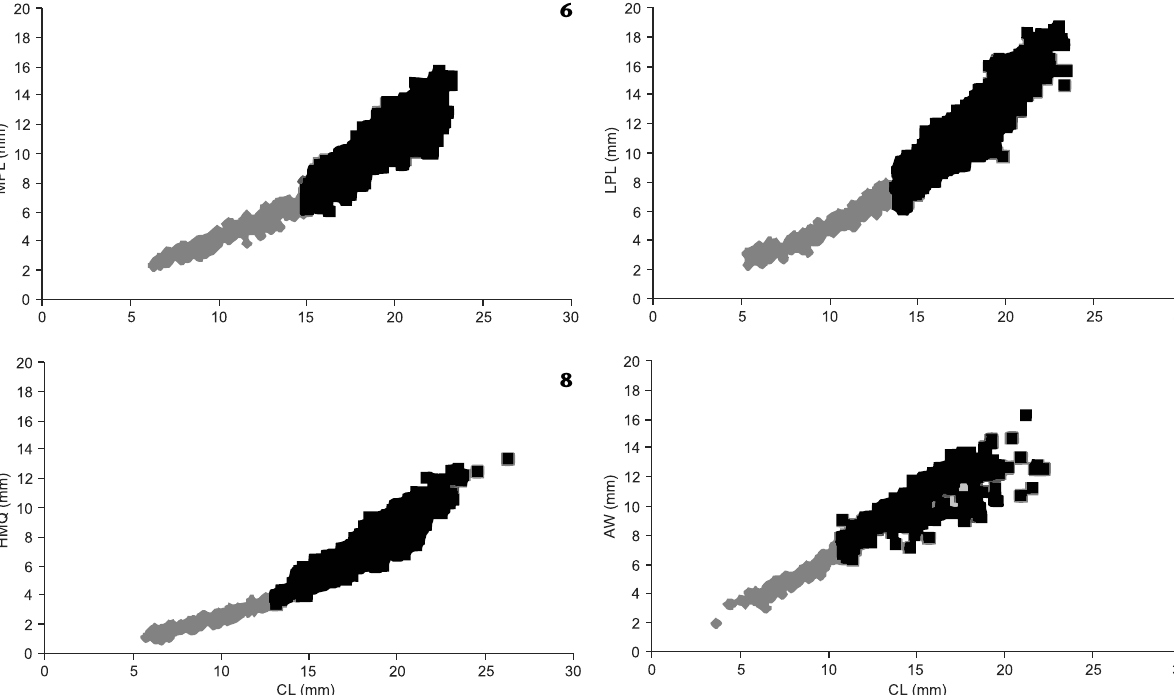
Figures 6-9. Dispersion diagrams that analyse the morphological sexual maturity of Aegla georginae in Perau Creek, Ibicuí Basin, Brazil. (6-8) Males: (6) CLxMPL, n = 972; (7) CLxLPL, n = 951; (8) CLxHMQ, n = 915; (9) females, CLxAW, n = 976. Dark points = adults, Grey points =